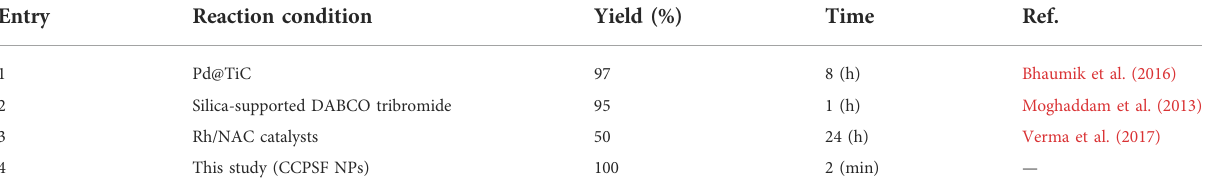
TABLE 5 Different catalysts recently reported for the oxidation of benzyl alcohol. Entry Reaction condition Yield (%) Time